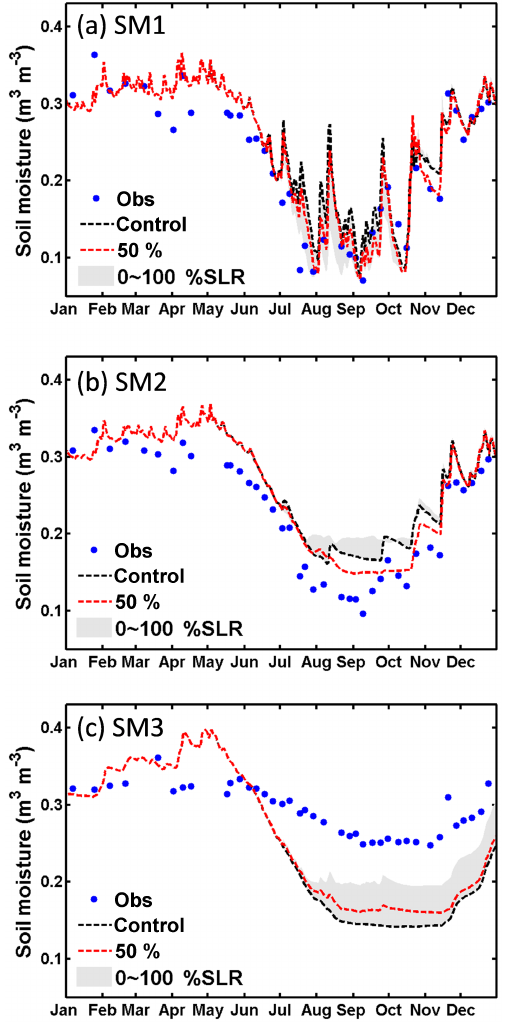
Figure 6. Same as Fig. 5, but for the HAPEX case at depths of (a) SM1 (0–20cm), (b) SM2 (20–50cm) and (c) SM3 (50–160cm). Red dashed curves are results with SLR =